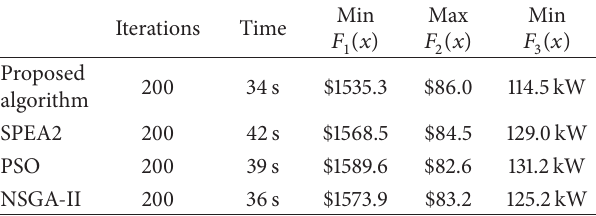
Figure 10: Hourly bill saving for consumers with DG unit injection. Table 3: Comparison of different